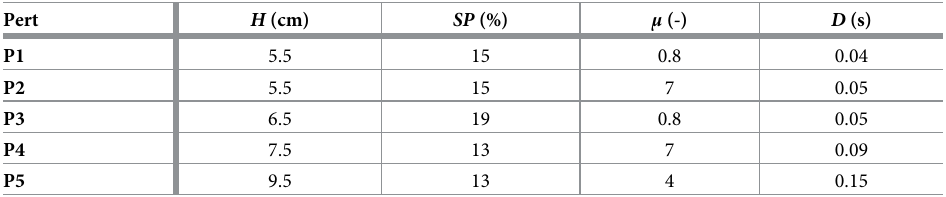
Table 1. Perturbation